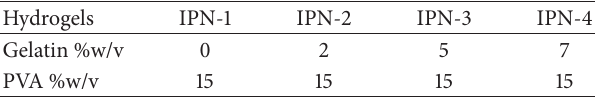
Table 1: Composition of IPN PVA/GE